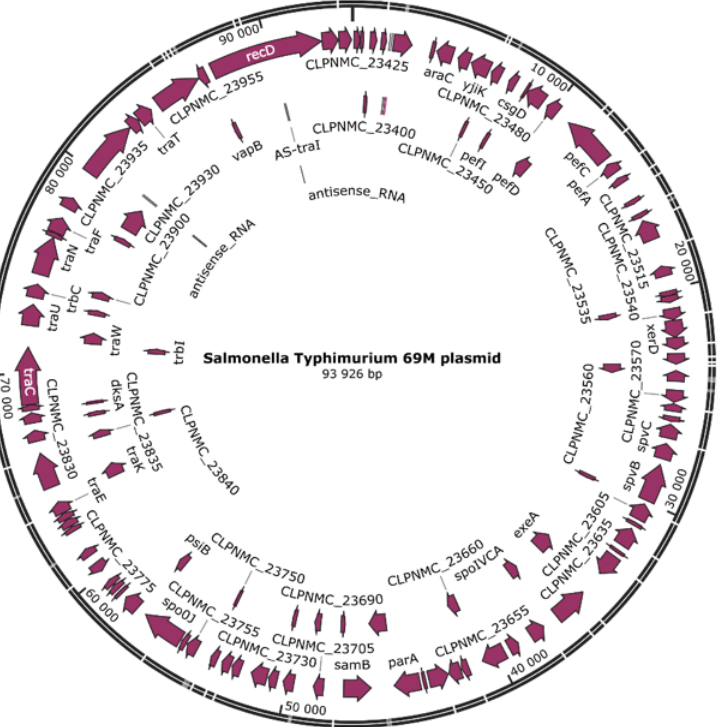
Figure 2. A circular graphic of the IncFIB(S) plasmid found in the Salmonella Typhimurium 69M sequence. The length of the plasmid is 93926 bp, and the virulence genes carried by the IncFIB(S) are marked with maroon arrows (created in SnapGene 6.0.3 (www.snapgene.com on 2 February 2023)).